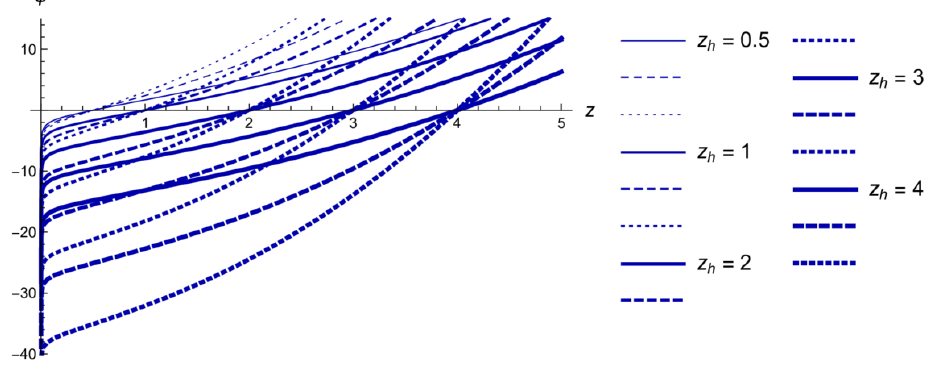
Figure 3 . Scalar (cid:12)eld (cid:30) ( z ) for (cid:23) = 4 : 5, c = (cid:0) 1 (solid lines), c = (cid:0) 2 (dashed lines) and c = (cid:0) 3 (dotted lines) and di(cid:11)erent z h